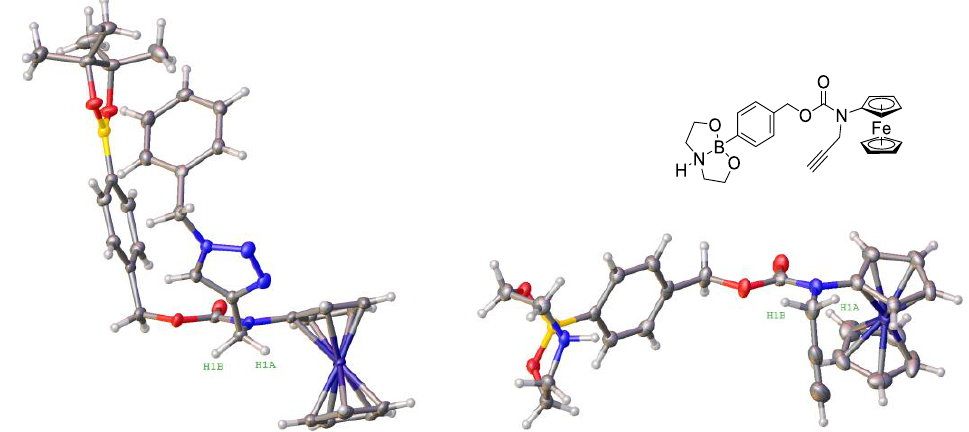
Figure 2. Comparison of the molecular structures of prodrug 2a (left structure) and previously published 4-( N -ferrocenyl- N -propargylaminocarbonyloxymethyl)phenylboronic acid N , N -diethanolamine ester (right structure [27]).